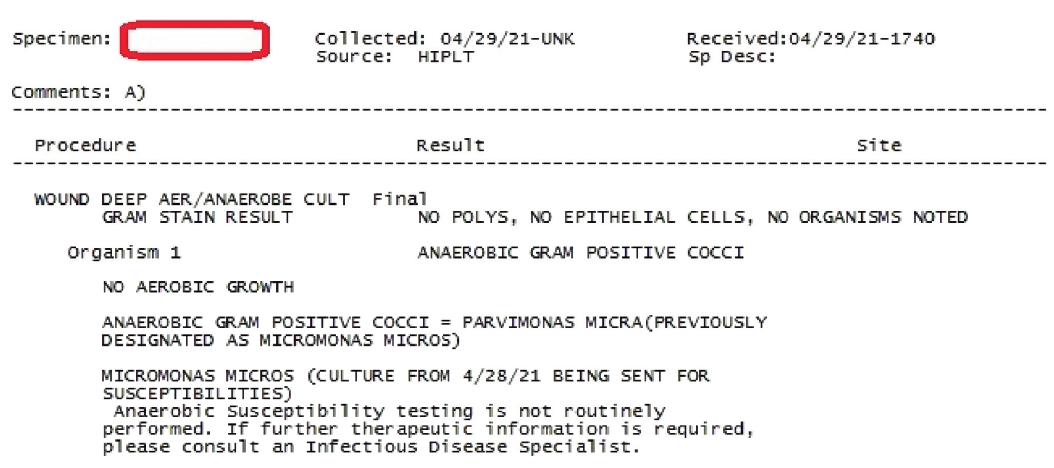
Figure 2: Details of hip aspirate culture results.